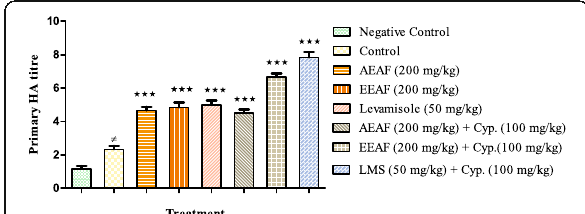
Fig. 9 Effect of AEAF and EEAF on Secondary HA titre. Results were expressed as mean ±SEM, ( n = 6). Statistical analysis was performed with one-way analysis of variance (ANOVA) followed by Tukey- Kramer multiple comparison test. # P < 0.05, ## P < 0.01 as compared with NC. P value less than < 0.05 was considered to be